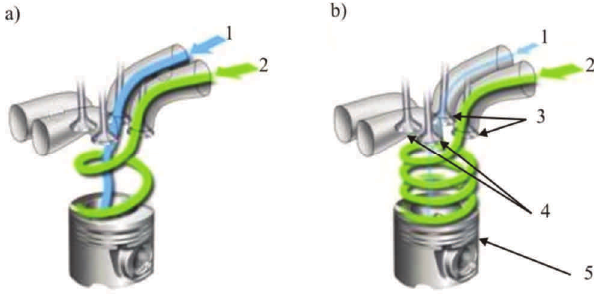
Fig. 4. The examples of swirl generation system by flow regulation [14]: a) – low swirl condition, b) – high swirl condition, 1 – flux flow by inlet canal, 2 – flux flow by inlet swirling canal, 3 – inlet valves, 4 – exhaust valves, 5 –